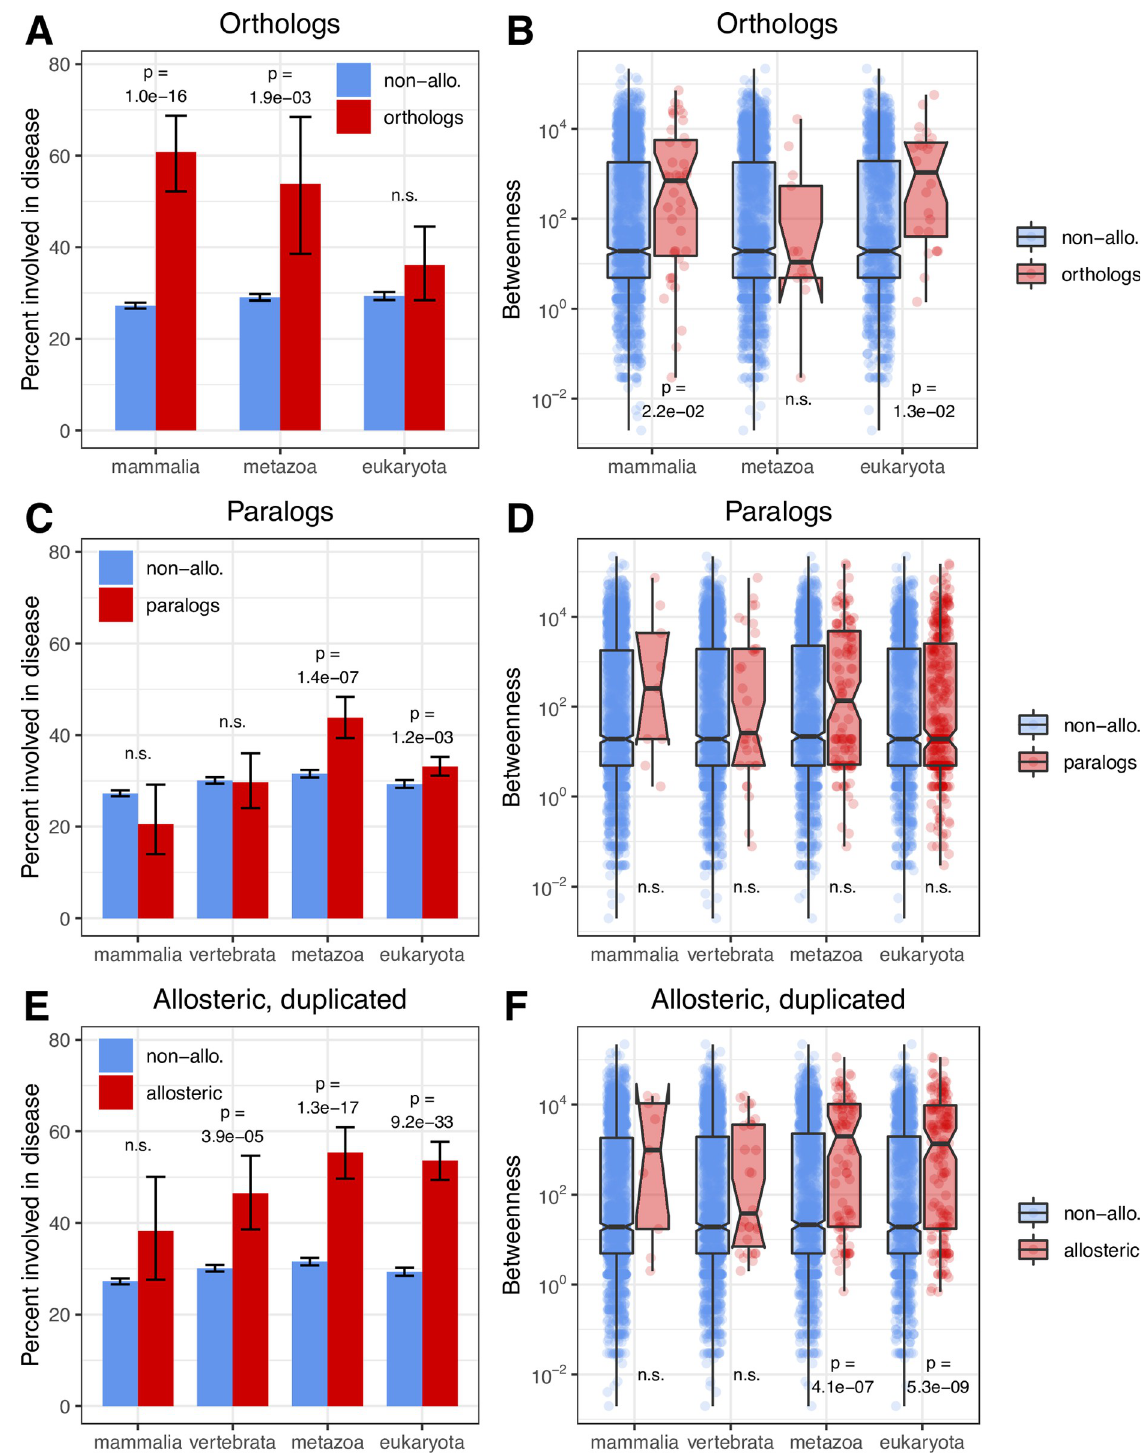
Fig 3. Human orthologs and paralogs of known allosteric proteins, and which are not present in the allosteric dataset have different disease properties. Orthology and paralogy have different consequences for functional conservation: orthologs usually have similar functions in different species, while paralogs, due to being released from selective pressure after duplication evolve and acquire new functions rapidly. A-B) Similarly to known human allosteric proteins, human orthologs of non-human allosteric proteins are enriched in disease, and have high betweenness centralities in the disease network. C-D) Paralogs of human allosteric proteins show no, or only weak importance in disease.